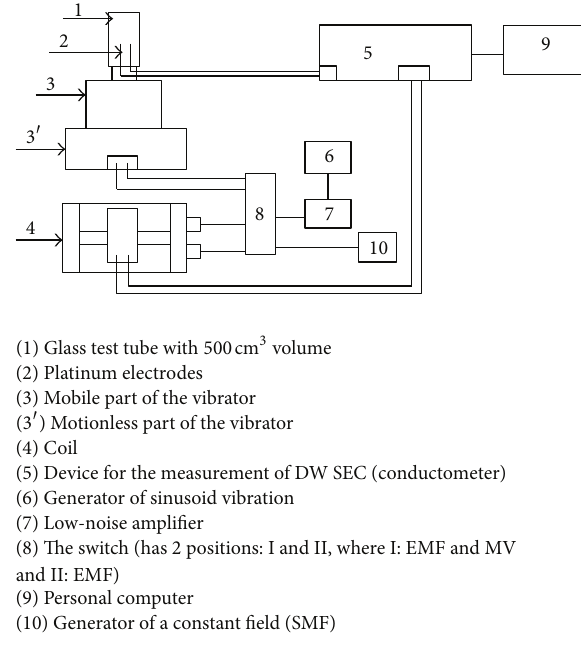
Figure 2: Setup for treatment of DW by NIR: (1) glass test tube with 500 cm 3 10 mL; (2) platinum electrodes; (3) mobile part of the vibrator; (3 󸀠 ) motionless part of the vibrator; (4) coil; (5) device for the measurement of DW SEC (conductometer); (6) generator of sinusoid vibration; (7) low-noise amplifier; (8) the switch (has 2 positions: I and II, I: EMF and MV and II: EMF); (9) personal computer; (10) generator of a constant field